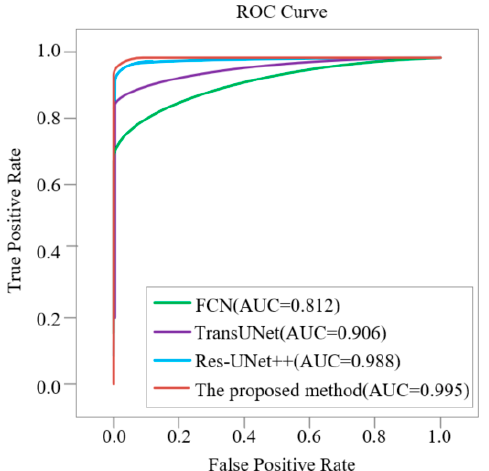
Figure 9. Comparison of ROC curves of different models on the macular edema OCT images test set with multi-scale and multi-region.